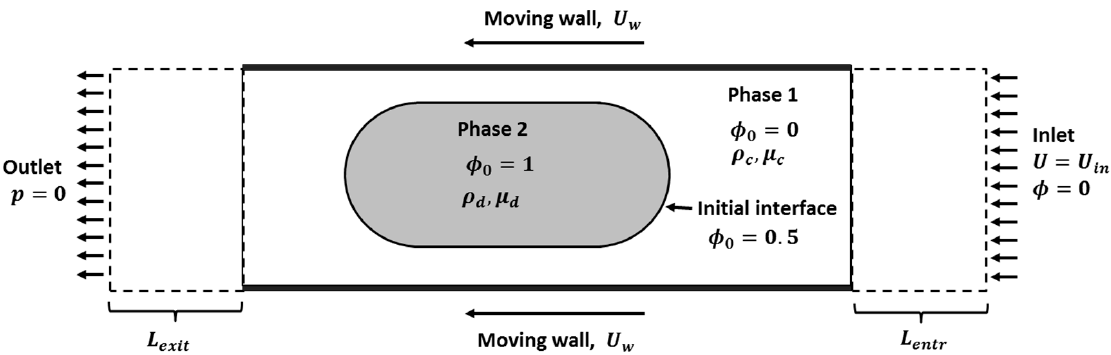
Figure 3. Initial and boundary conditions for a droplet travelling in microchannel modelled using a two-phase moving frame of reference.